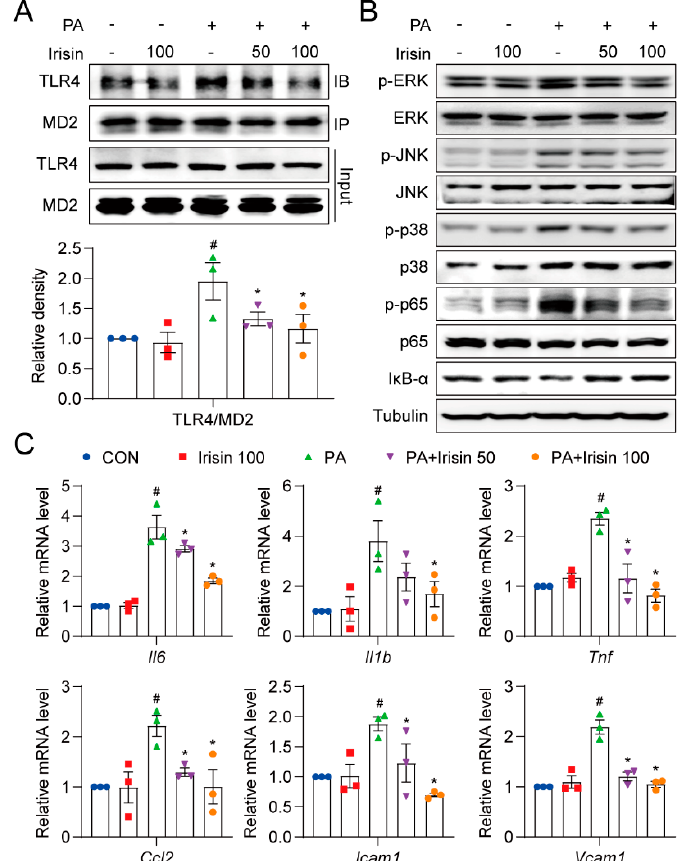
Figure 7. Irisin blocks NF- κ B and MAPK pathways, and reduces inflammatory factors in AML12 cells. ( A , B ) AML12 cells were pretreated with recombinant irisin (50 or 100 ng/mL) for 30 min followed by exposure to 200 μ M PA for 2 h. ( A ) MD2-TLR4 complex formation levels in AML12 cells detected by immunoprecipitation. ( B ) Protein levels of MAPK pathway and NF- κ B pathway components, including p-ERK, p-JNK, p-p38, p-p65, and I κ B- α . The corresponding unphosphorylated proteins and tubulin were used as loading controls. ( C ) AML12 cells were pretreated with recombinant irisin (50 or 100 ng/mL) for 30 min followed by exposure to 200 μ M PA for 12 h. Relative mRNA levels of Il6, Il1b, Tnf, Ccl2, Icam1, and Vcam1 were detected. The data are presented as the mean ± SEM. # p < 0.05 vs. CON group; * p < 0.05 vs. PA group.